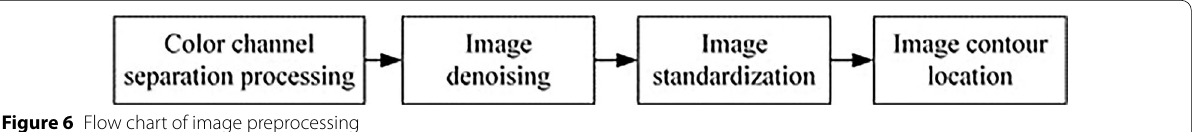
Figure 6 Flow chart of image preprocessing